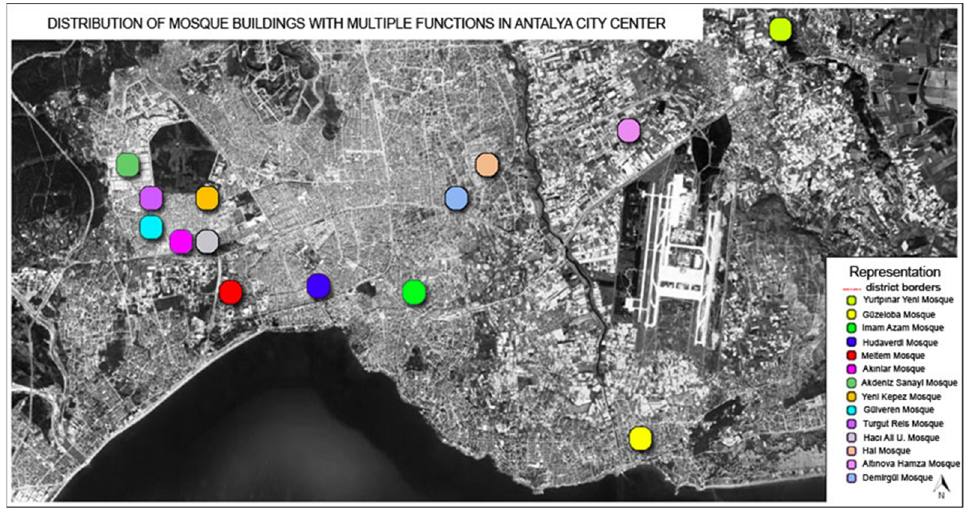
Figure 9. Distribution of mosques with trade functions in Antalya city center.